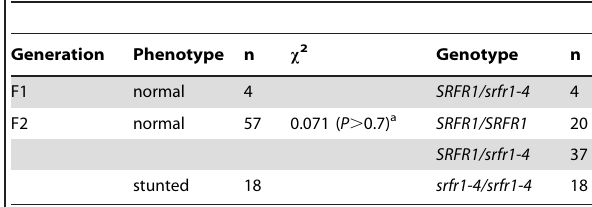
Table 1. The stunted phenotype co-segregates with the srfr1- 4 allele in a backcross to